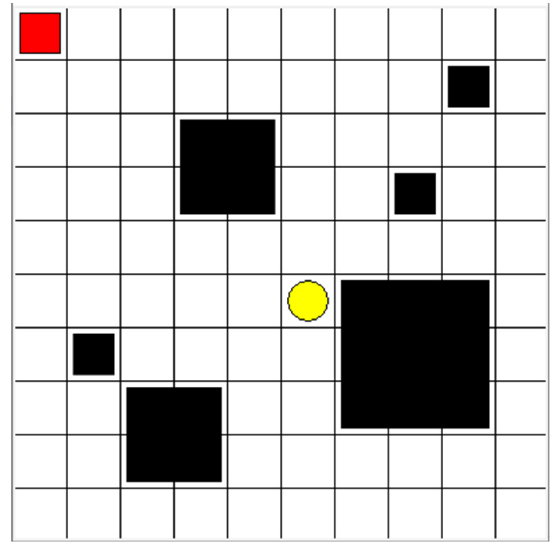
Figure 4. 10 × 10 original map.